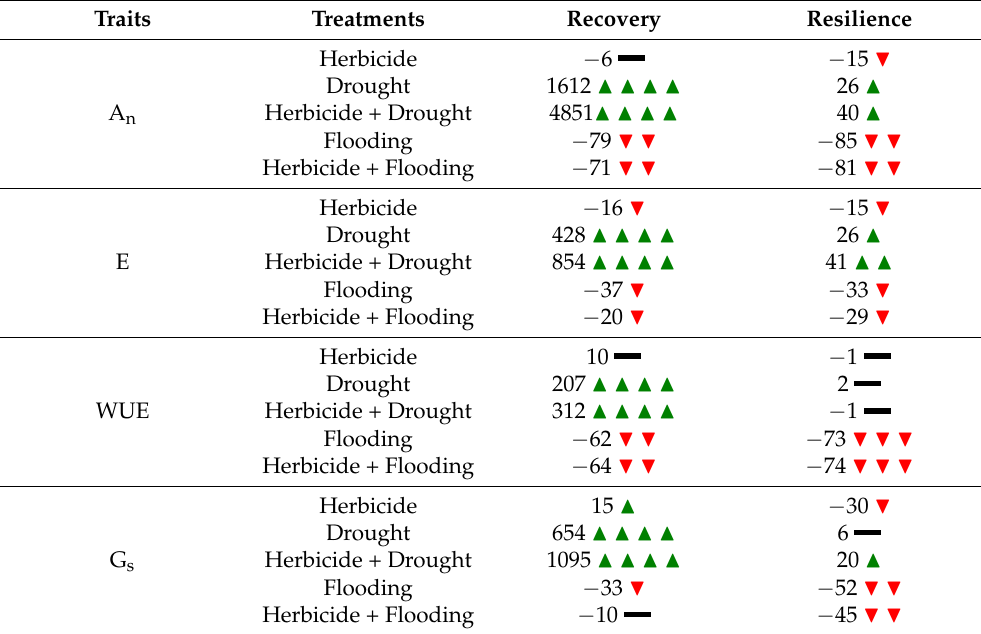
Table 1. Summary of the recovery and resilience indices of the photosynthesis functional traits in response to treatment with herbicide, drought and flooding